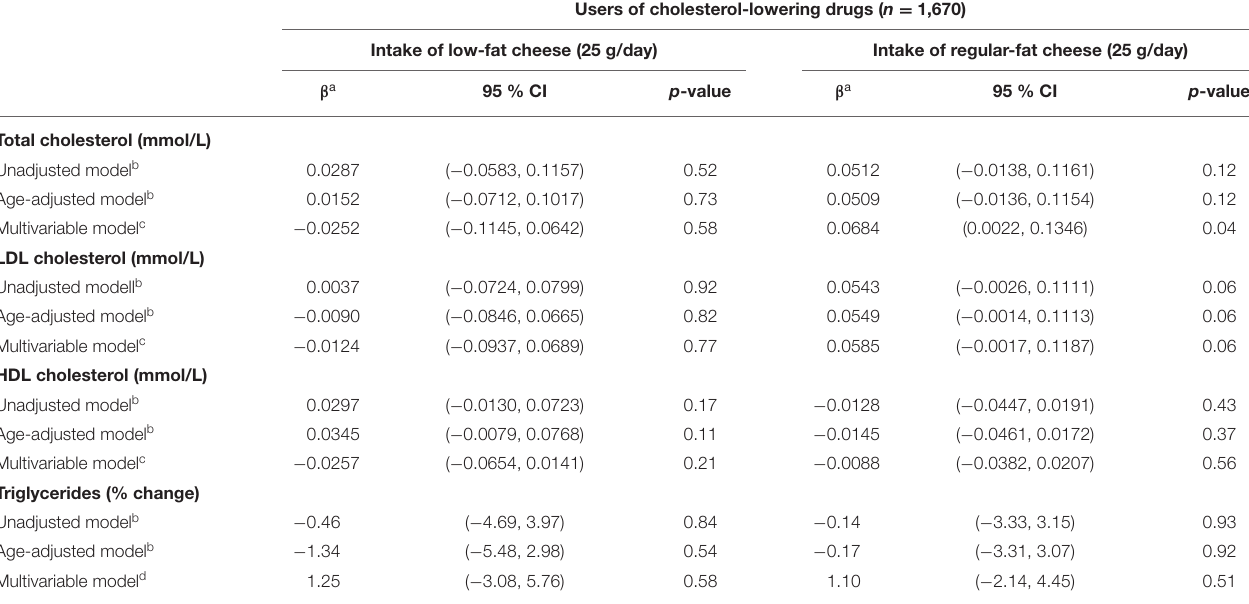
TABLE 7 | Linear regression coefficients for the associations between blood lipids and intake of low-fat cheese and intake of regular-fat cheese among users of cholesterol-lowering drugs ( n = 1,670). The Tromsø Study: Tromsø7. Users of cholesterol-lowering drugs ( n = 1,670) Intake of low-fat cheese (25